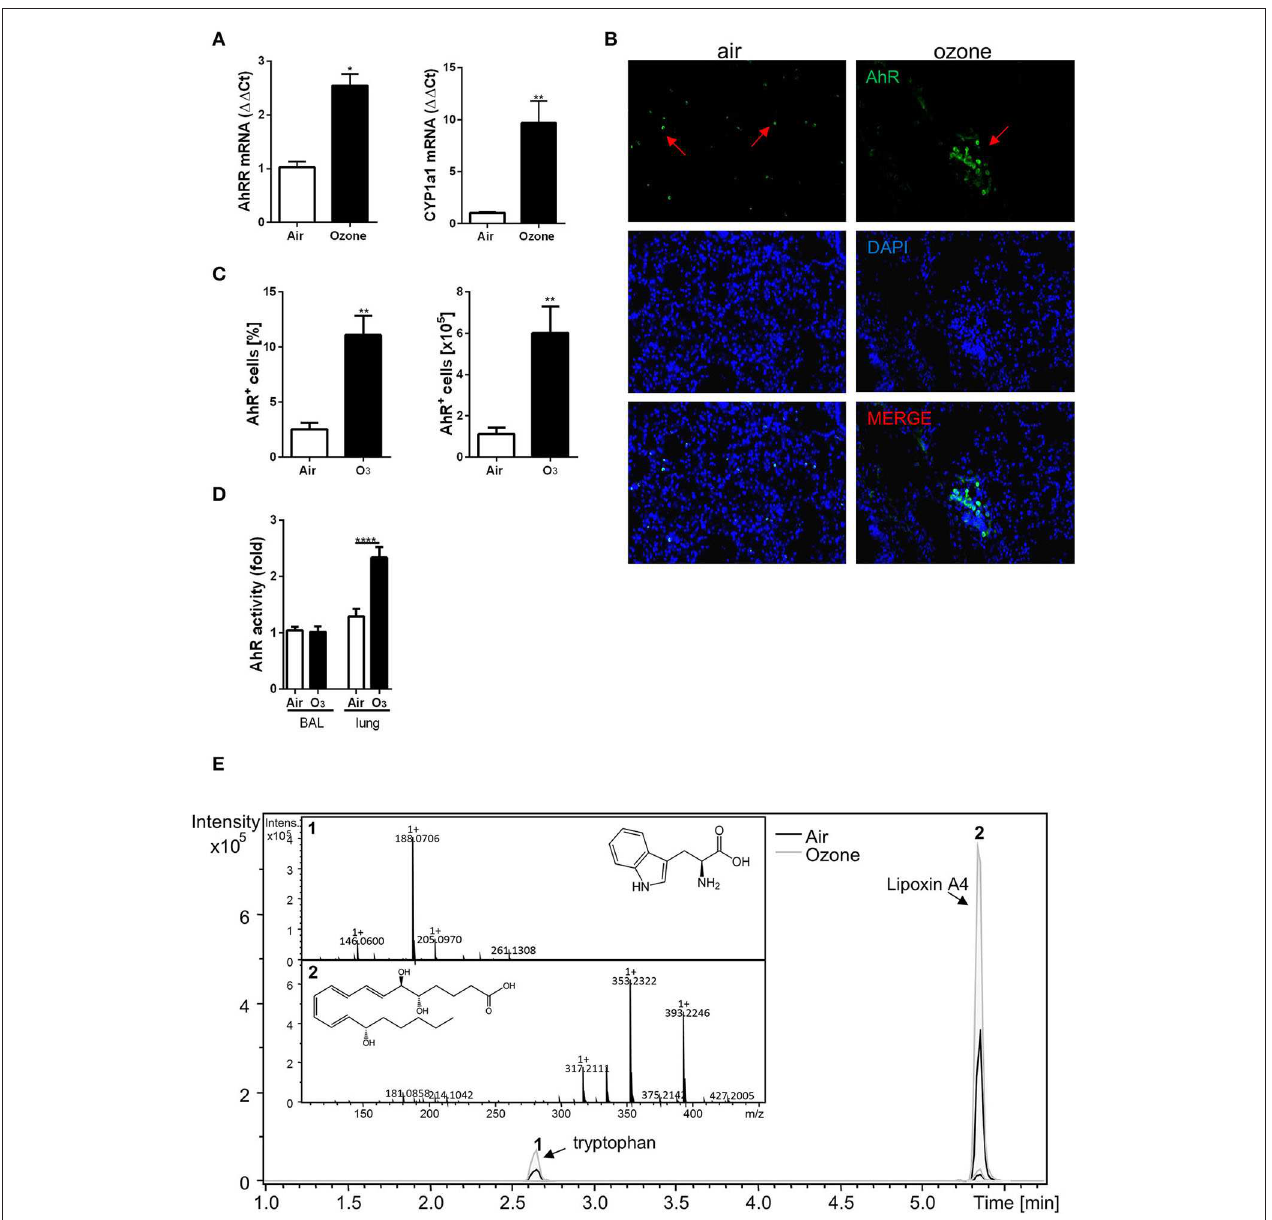
FIGURE 1 | Chronic ozone exposure induces AhR activation. Quantification of AhRR and Cyp1a1 involved in the AhR pathway activation (A) . AhR detection in lung, by immunofluorescence staining (magnification 400 × ; arrows represent AhR + cells) (B) and FACS (C) . AhR activity in the BAL and the lung after 6 weeks ozone exposure (D) . Relative abundance of tryptophan and Lipoxin A4 in lung supernatant analyzed by LC-MS (E) . The data are representative of one from two independent experiments with n = 5–6 mice per group. Values are expressed as mean ± SEM. Statistical significance was defined at a p -value **** < 0.0001, *** < 0.001, ** < 0.01, and * <